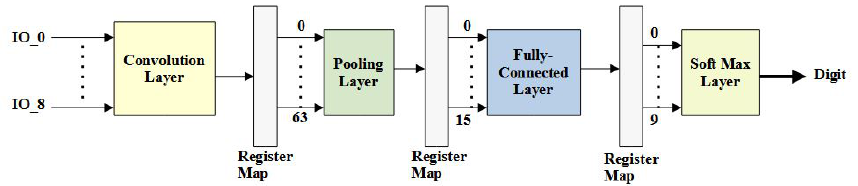
Figure 13. System construction on